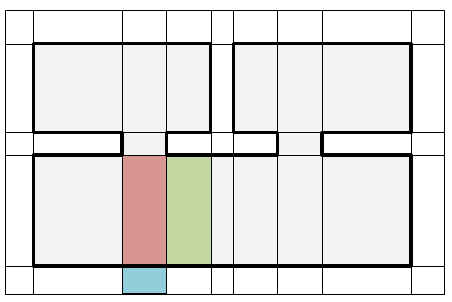
Figure 7. Illustration of two pairs of adjacent cells of an indoor space depicted in Figure 6a expressed in 2D for visualization. The area occupied by structural points located on the adjacent face of red and green cells is close to zero, while that of red and blue cells is close to the area of face shared by the two